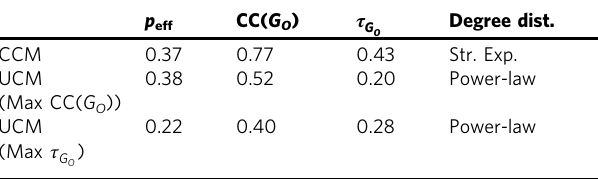
Fig. 5 The observed degree distributions for the general correlated copying model (GCCM). The degree probability, p O ( k O ), is plotted as a function of the observed degree, k O , for various values of the outer copying probability, p obs (left to right), and the hidden copying probability, p hid (bottom to top). For p ∈ {0, 0.25, and 0.5}, each network contains 10 6 nodes. For p obs nodes. Distributions are averaged over 100 instances. In the dense regime ( p obs > 0.5), network growth is non-ergodic leading to anomalous scaling and noisy degree distributions. The distribution at p hid = p obs = 0 corresponds to a random recursive tree, see Eq. (3) (exponential decay). The distribution at p = p = 1 corresponds to a complete graph. The distribution at p hid obs equivalent to the uniform copying model. Table 1 A comparison between the correlated copying model (CCM) and the uniform copying model (UCM).